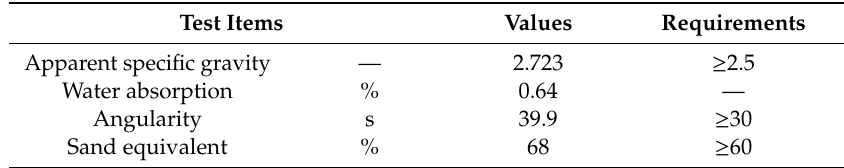
Table 3. Technical properties of basalt fine